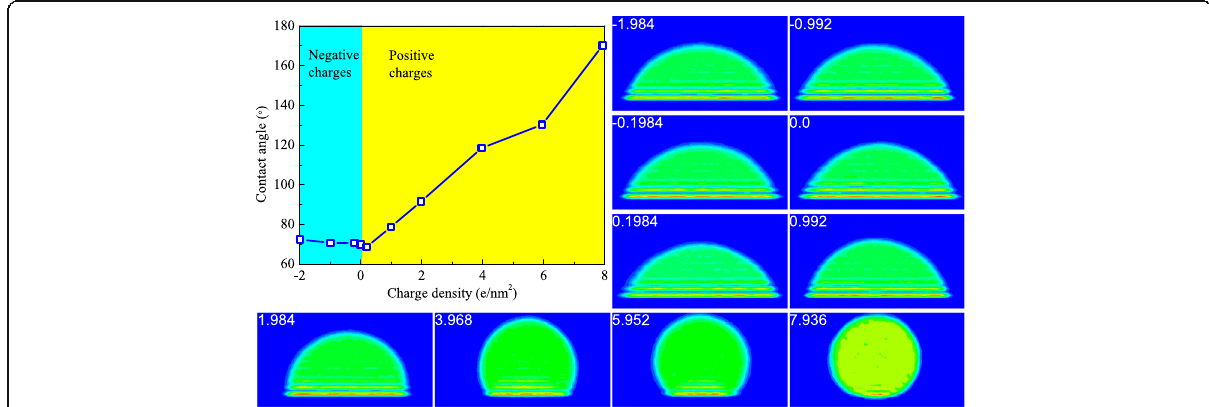
Fig. 3 Variation of contact angles with the surface charge density. The contour images of oil droplets at different surface charge densities are also